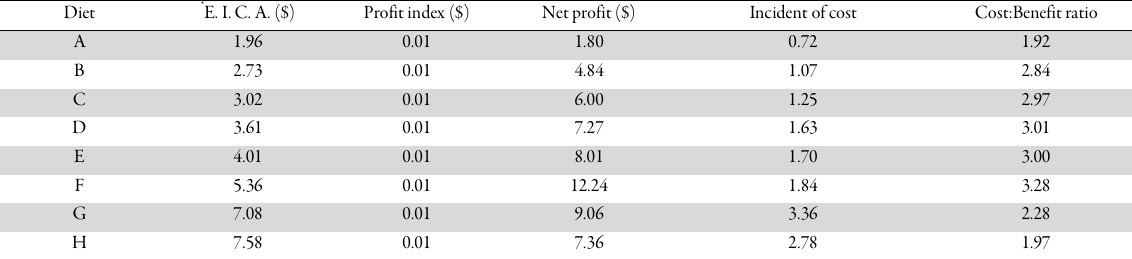
Table 6. Economic analysis of diets